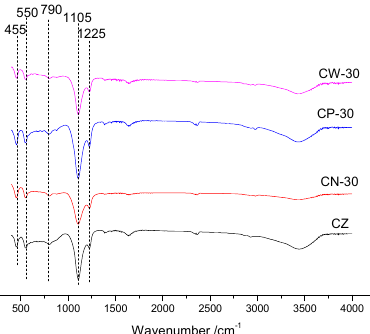
Figure 2. FT ‐ IR spectra of the catalysts’ structure. Figure 2. FT-IR spectra of the catalysts’ structure.